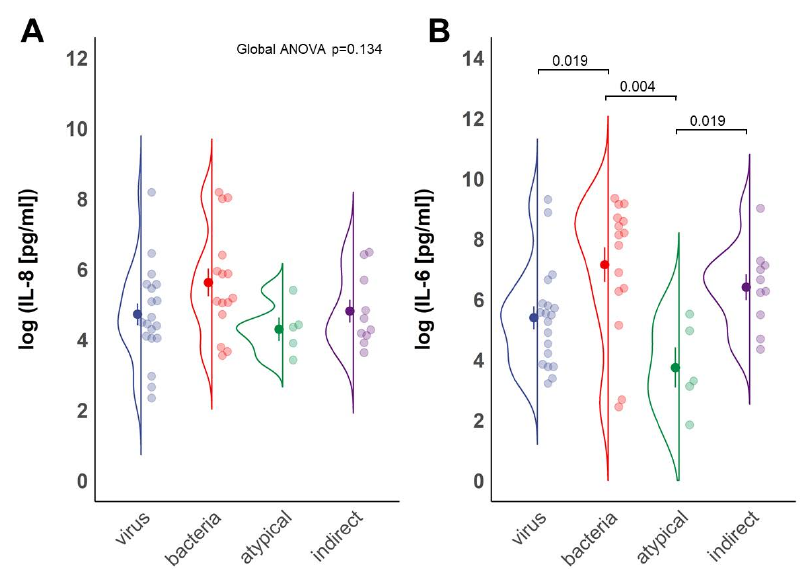
Figure 2. IL-6 and IL-8 serum concentrations in patients with different ARDS sub-phenotypes. Blood samples of patients classified as described in Figure 1 were analyzed for ( A ) IL-8 and ( B ) IL-6 concentrations. Mean ± SD of log-transformed data is shown, pairwise t -tests with Benjamini– Hochberg adjustment after global